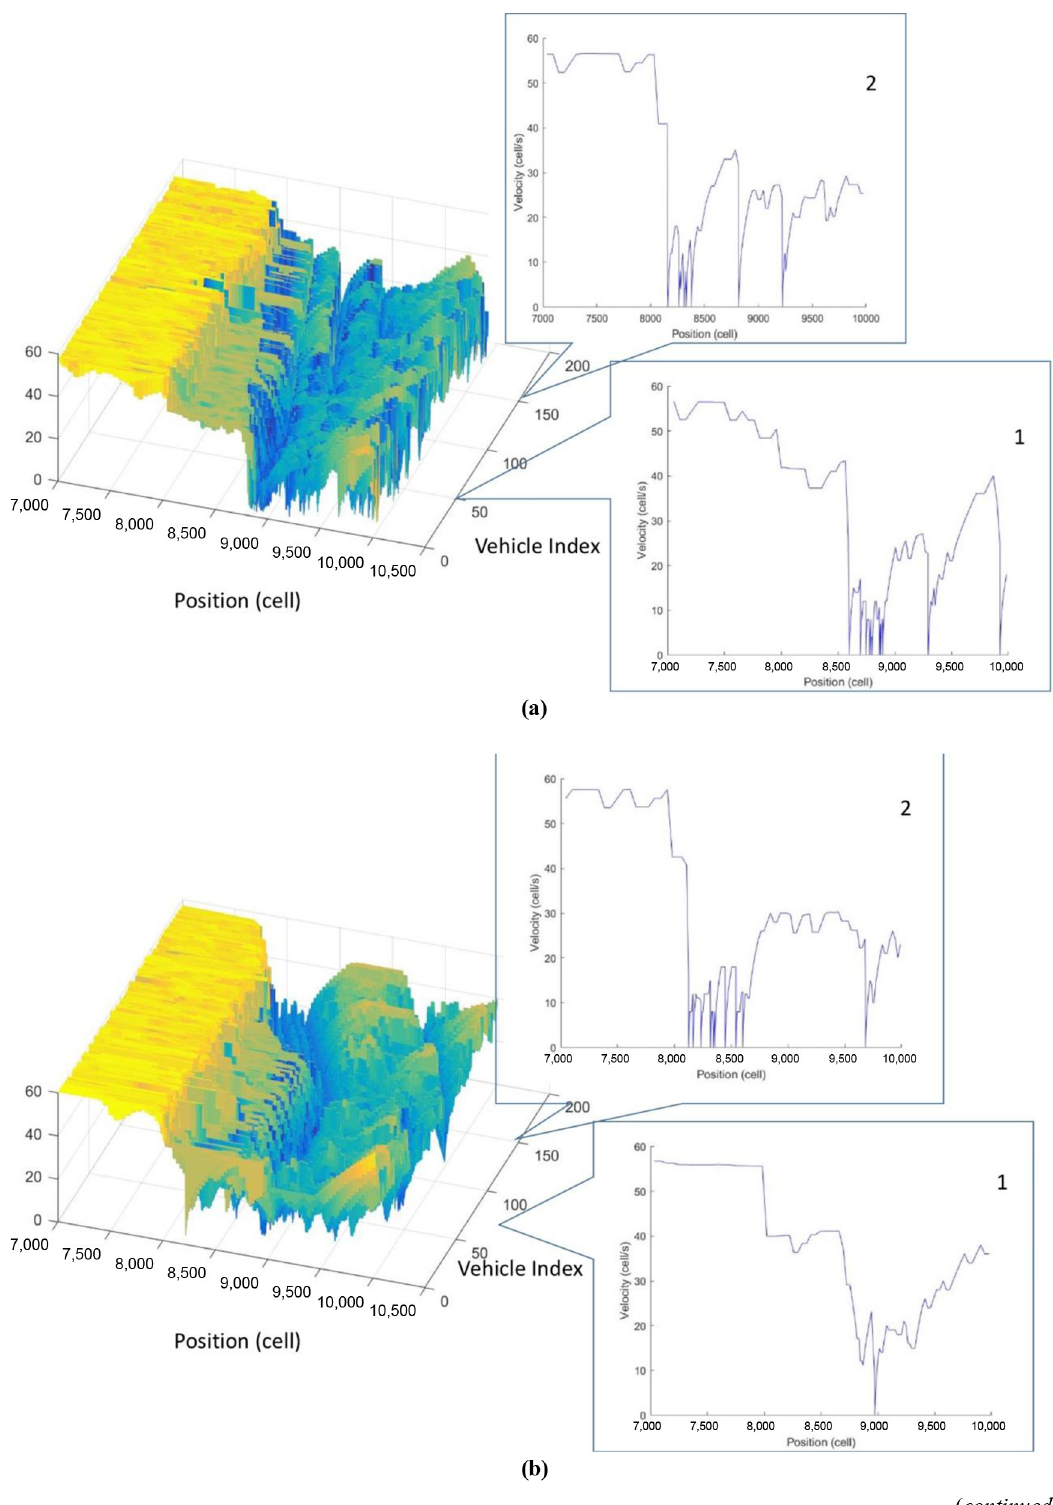
Figure 11 Velocities over locations around the work